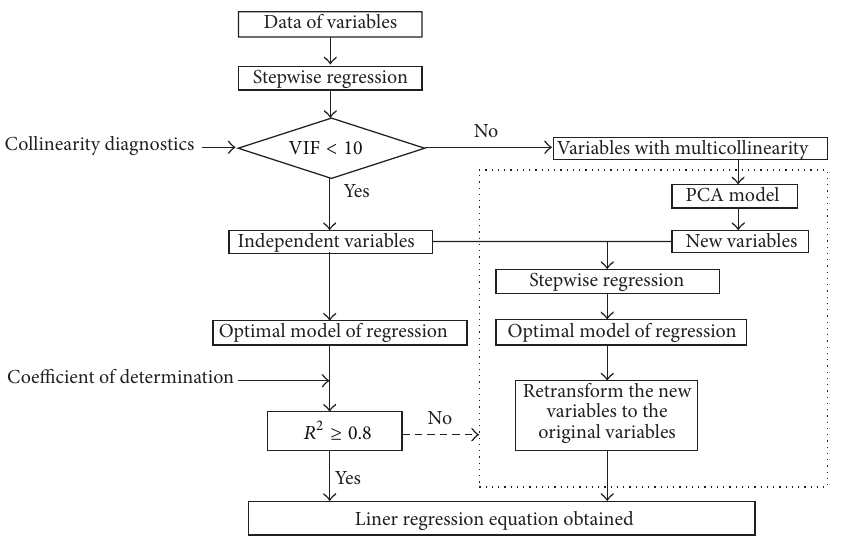
Figure 1: Flowchart of irrigation water use efficiency